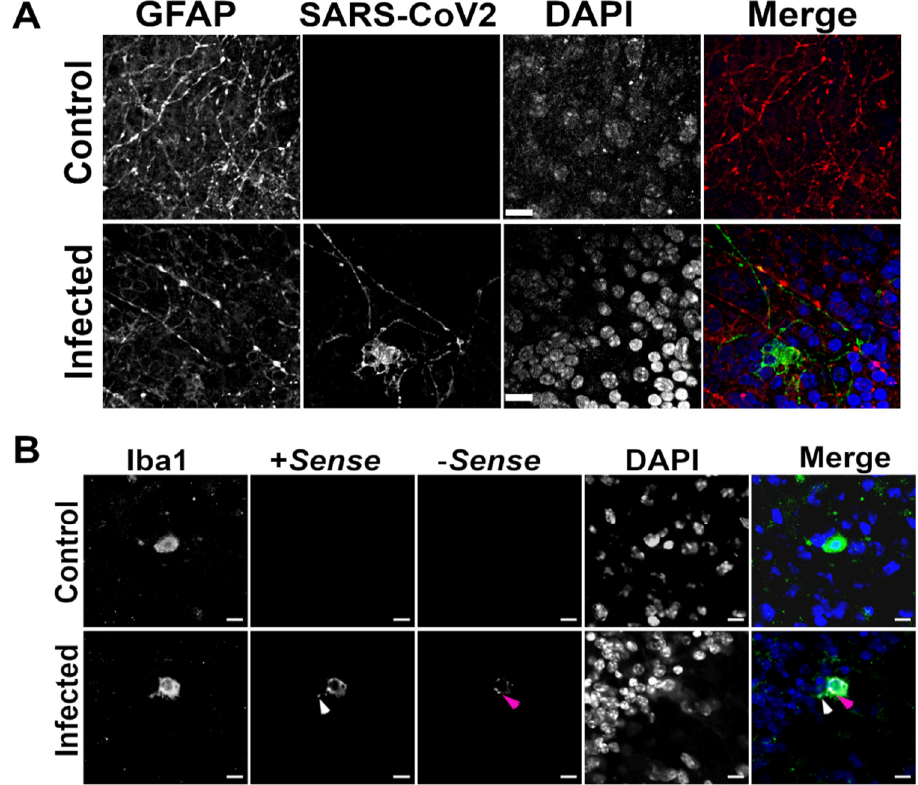
Figure 4. SARS-CoV-2 may infect glial cells in a hamster brain cerebellar slice culture. Representative images of hamster brain cerebellar slices identifying either astrocytic (Gfap (red); ( A )) or microglial (Iba1 (green); ( B )) markers and SARS-CoV-2 nucleopasid (green; ( A )) or +sense (white arrowheads (red); ( B )) or -sense (magenta arrowheads (yellow); ( B )) viral RNA strands. Nuclei were counter- stained with DAPI/ blue; merge depicts a composite image. Scale bar = 10 µ m. We also calculated the corrected total intensity of each marker to compensate for background fluorescence (Supplementary Figure S4). Additionally, since both β 3-Tubulin and Map2 were cytoskeletal markers, we used NeuN, a nuclear marker for neurons, to prevent unconscious observational bias of the surrogate markers we used. We found no overlap in fluorescence signals from probes identifying SARS-CoV-2 and NeuN. These data further confirm our observation that SARS-CoV-2 does not infect hamster neurons in organotypic cerebellar brain